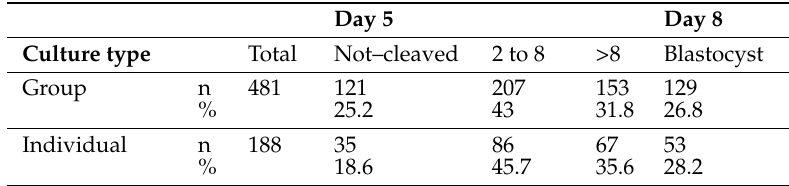
Table 1. Comparison of group and individual embryo culture. Comparison of cleavage and further development of bovine cumulus − oocyte − complexes (COCs)/zygotes cultured in groups or individually.